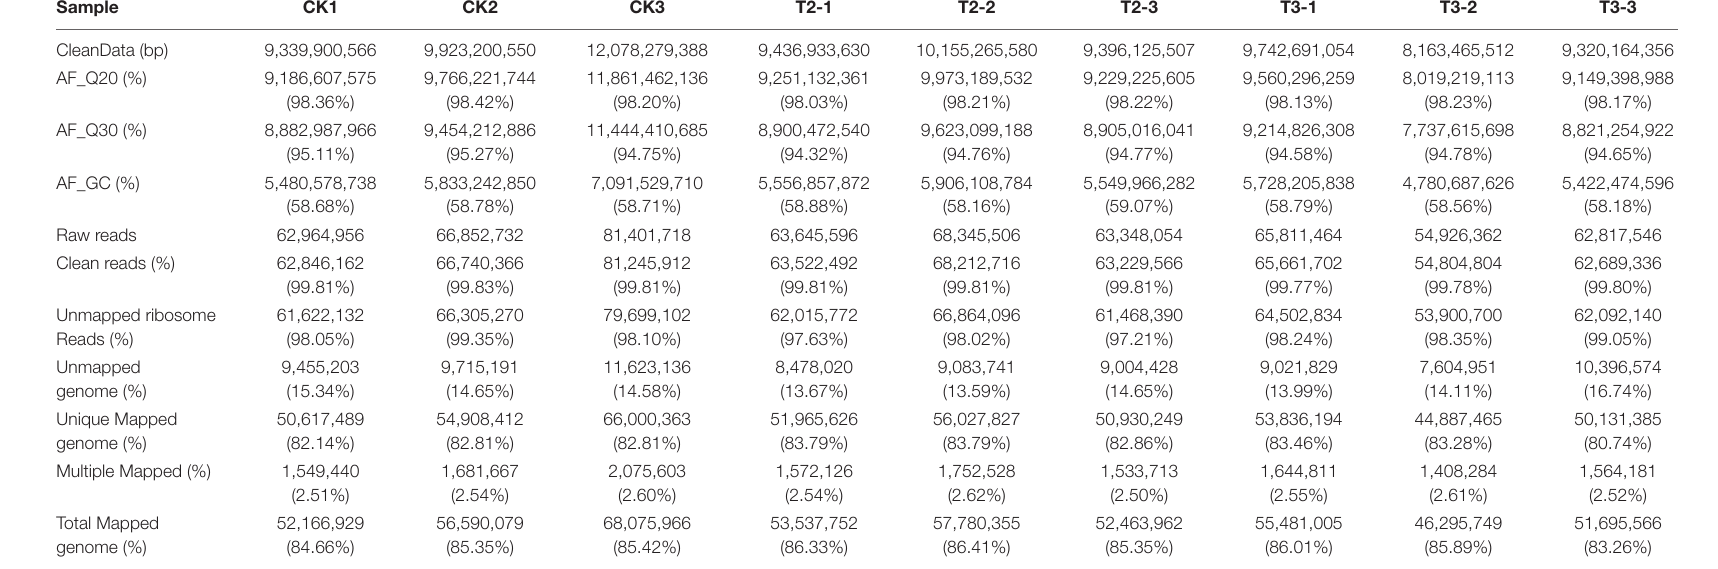
TABLE 1 | Number of reads sequenced and mapped to the maize genome.